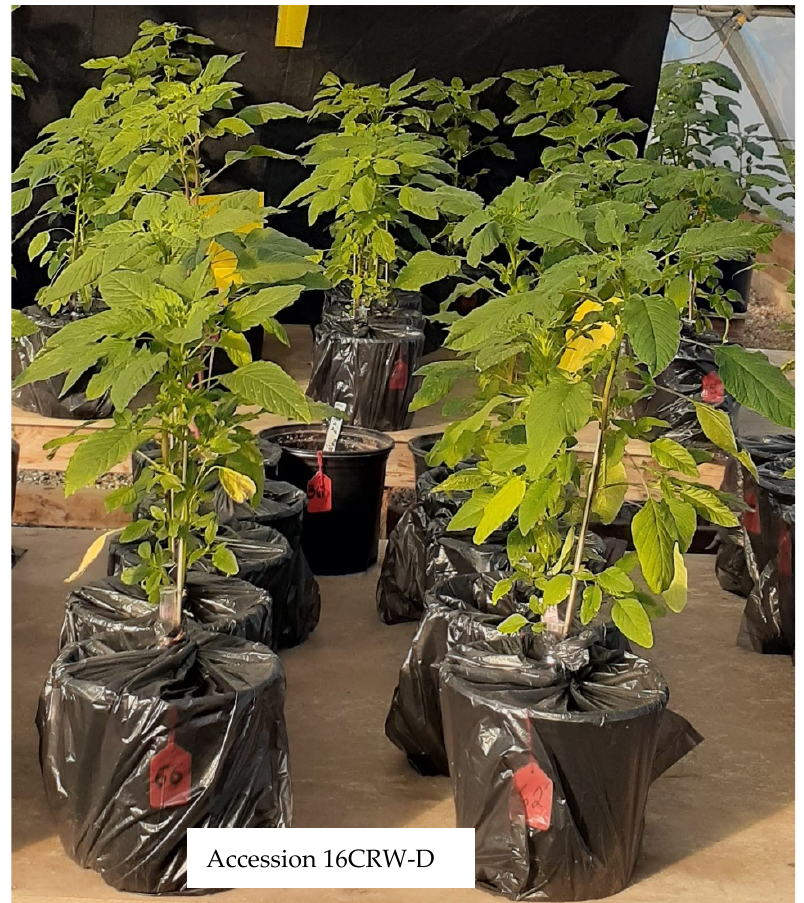
Figure 1. Setup of a greenhouse experiment to evaluate the transpiration responses of herbicide- resistant and -susceptible Palmer amaranth ( Amaranthus palmeri (S.) Wats.) to progressively drying soil, at the Shult Agricultural Research & Extension Center, University of Arkansas, Fayetteville, AR, USA, in 2021.